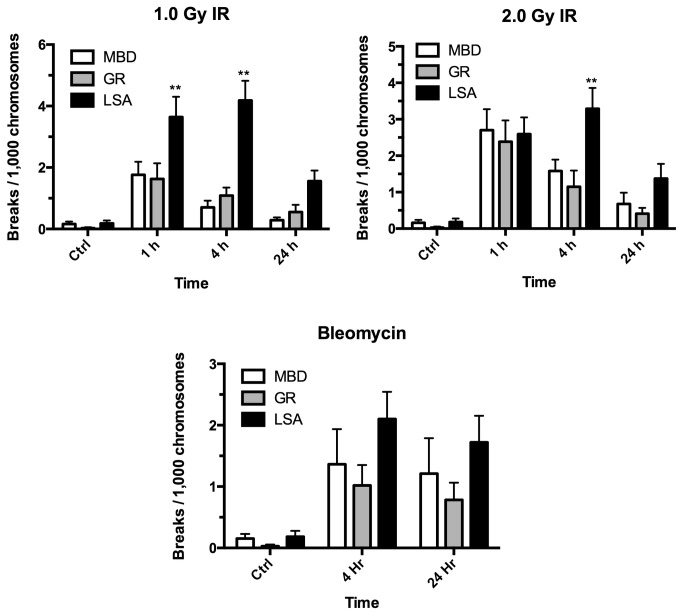
Chromatid-type aberrations in canine lymphocytes challenged with clastogen exposure.Stimulated lymphocytes (growing exponentially) from normal mixed breed dogs (MBD), healthy golden retrievers (GR) or golden retrievers with lymphoma (LSA) were exposed to 0.0 (control), 1.0 or 2.0 Gy IR, arrested in mitosis and chromatid breaks enumerated at 1, 4 and 24 hr. Spontaneous levels of chromatid breaks were not significantly different between the groups (p > 0.05). However, across all times following IR challenge, significantly higher frequencies of chromatid breaks were observed in golden retrievers with lymphoma compared to normal MBD or healthy GR (p < 0.0001 and 0.0089 for 1.0 Gy and 2.0 Gy respectively); increases at 24h were not statistically significant. Similar trends were observed with bleomycin treatment (p = 0.088). ** = time-points of significant difference by 2-way repeated measures ANOVA/Tukey multiple comparisons post-test. Error bars represent SEM.